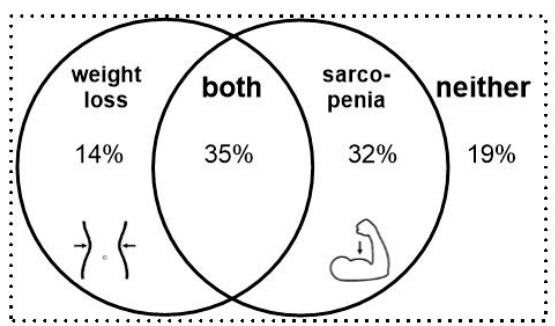
Figure 2. Distribution and combination of weight loss and sarcopenia observed between planning CT and first follow-up.